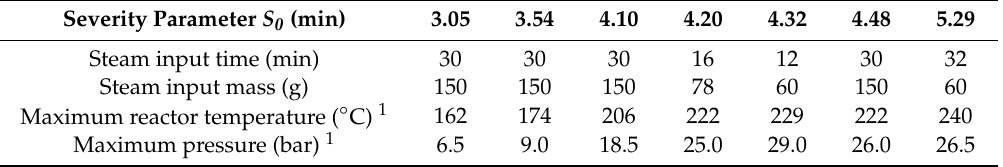
Table 2. Experimental setup for steam explosion of 27 g chipped rice